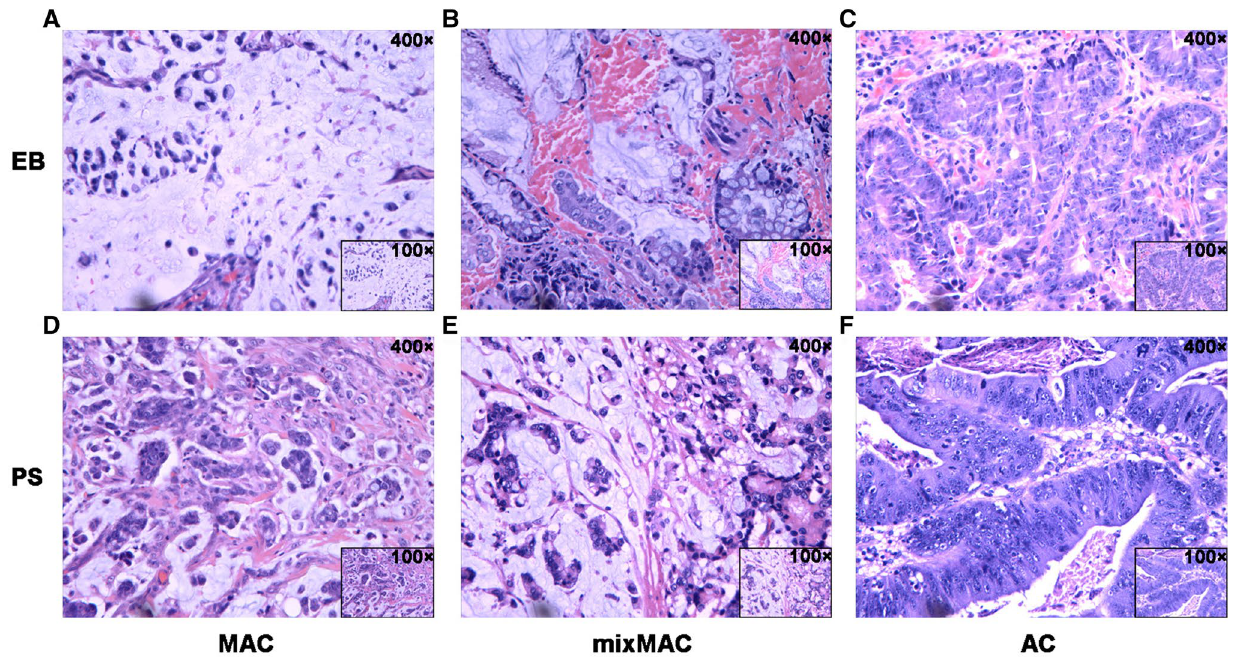
Fig. 1 The representative hematoxylin–eosin (HE) staining images of the histology subtypes of endoscopy biopsy and postoperative spec- imen. A Mucinous adenocarcinoma (MAC), B mixed MAC (mixMAC) and C non-specific adenocarcinoma (AC) from endoscopy biopsy; D MAC, E mixMAC and F AC from postoperative specimen